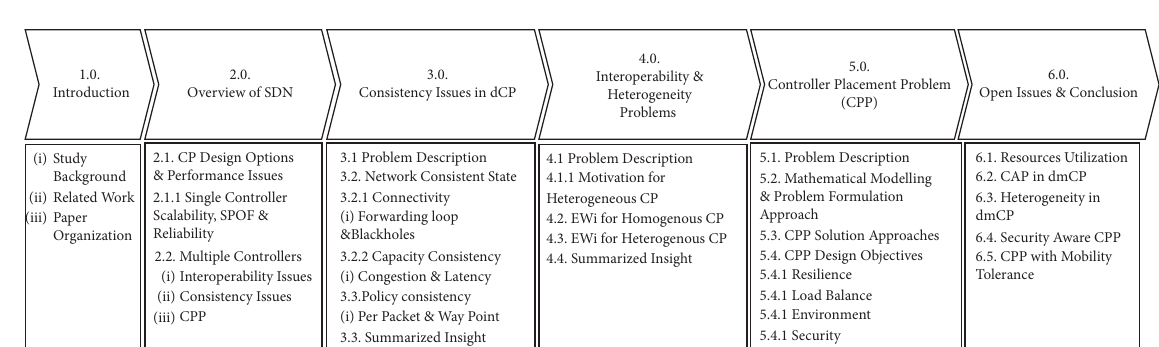
Figure 1: Organization of the review.